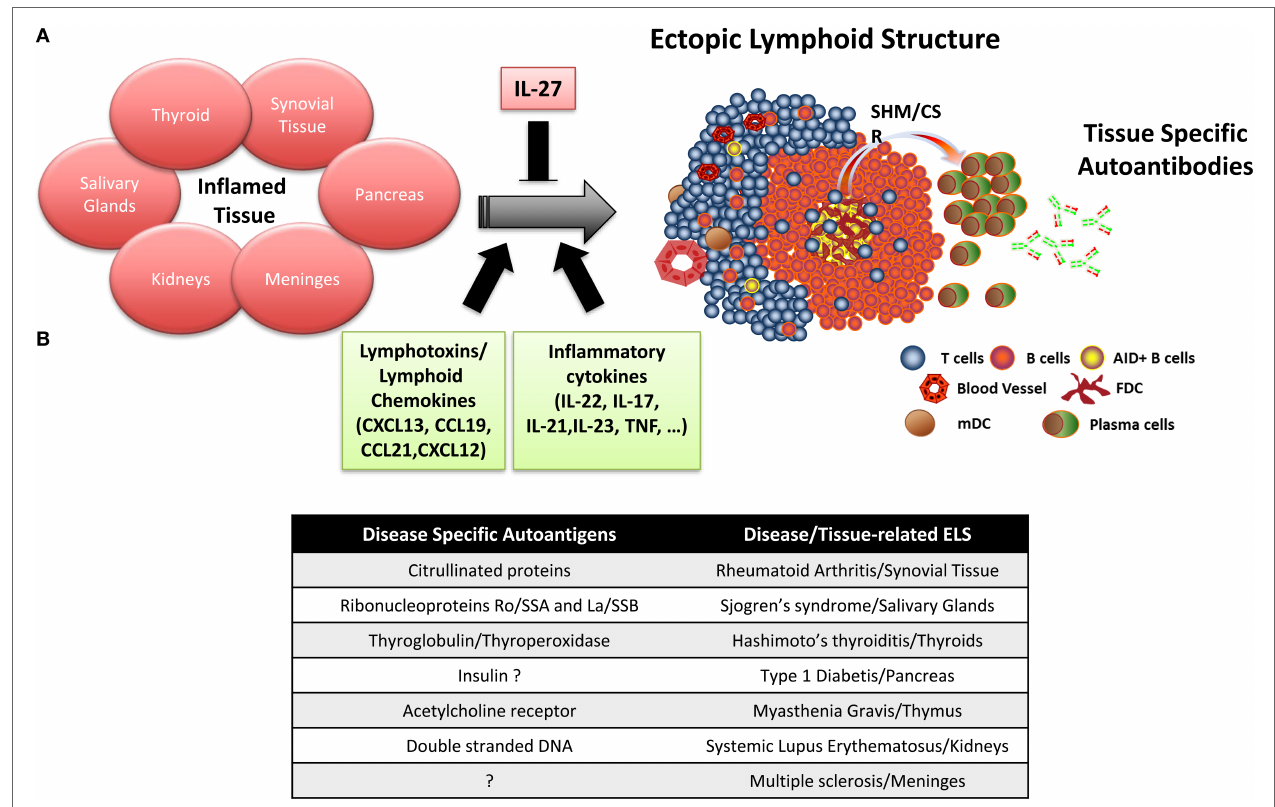
FiGURe 1 | ectopic lymphoid structure (eLS) formation in autoimmune disease tissue . (A) Importance of lymphotoxins/lymphoid chemokines and inflammatory cytokines in the formation and maintenance of ELS in the target organs of patients with autoimmune diseases, where ELS preferentially drives the affinity maturation and clonal selection of autoantibodies toward specific autoantigens. (B) Summary table listing the main disease-specific autoantigens and the associated autoimmune disease where ELS formation has been